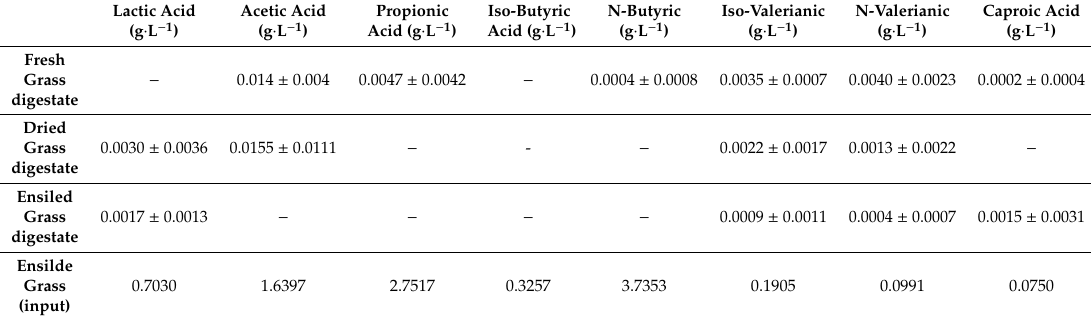
Table 3. Concentration of volatile fatty acids in the ensiled grass and in digestate from the tests. Lactic Acid Acetic Acid Propionic Iso-Butyric N-Butyric Iso-Valerianic N-Valerianic Caproic Acid (g · L − 1 ) (g · L − 1 ) Acid (g · L − 1 ) Acid (g · L − 1 ) (g · L − 1 ) (g · L − 1 ) (g · L − 1 ) (g · L − 1 ) − 0.014 ±